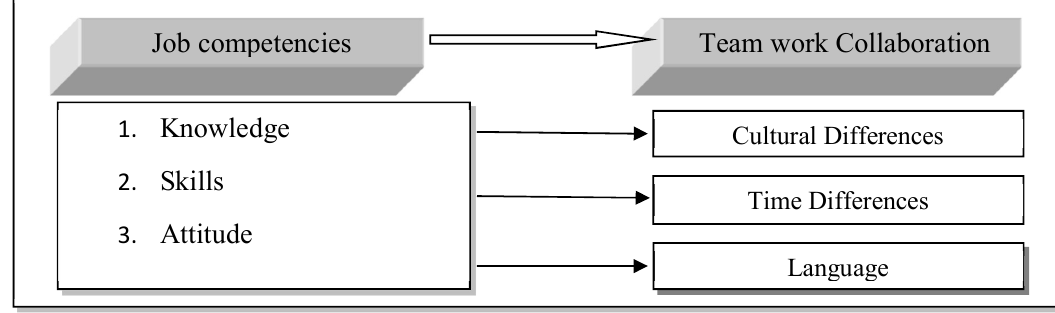
Fig. 1. The proposed